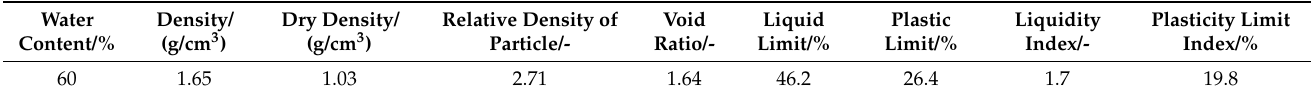
Table 1. Physical and mechanical properties of silty soil in Nansha District, Guangzhou. Table 2. Physical and mechanical parameters of polypropylene fiber.